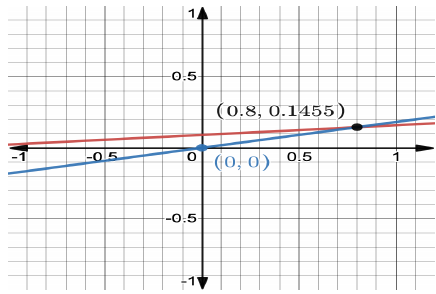
( x ) = 3 x + 4 (red) and G γ 2 44